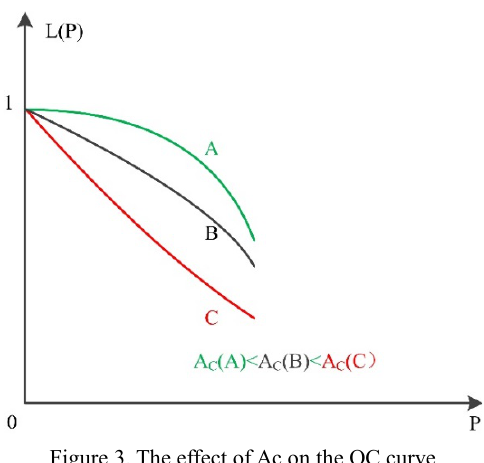
Figure 3. The effect of Ac on the OC